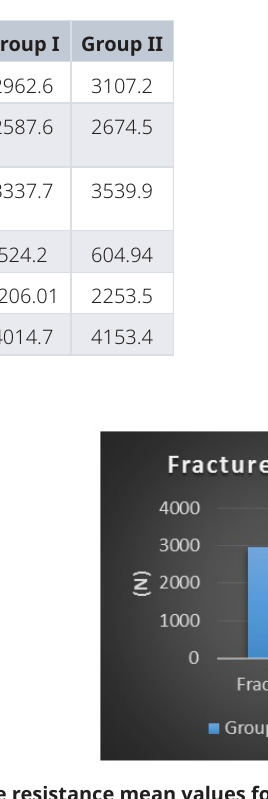
Table 4. Descriptive statistics of fracture resistance results as a function of preparation